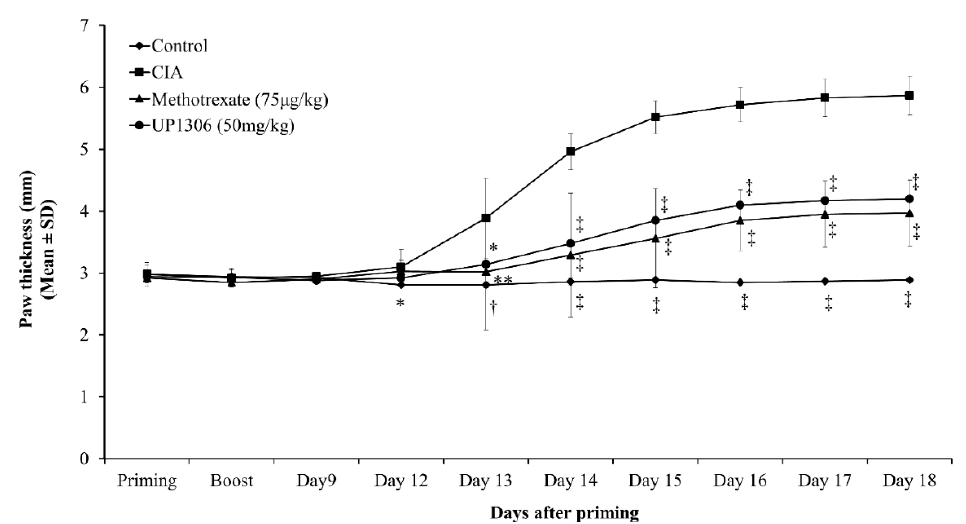
Figure 3. Changes in rat paw thickness in CIA model. Rats ( n = 10/group) were orally treated with UP1306 (50 mg/kg) and Methotrexate (75 μ g/kg) daily for three weeks post model induction. Data are mean ± SE. * p ≤ 0.05; ** p ≤ 0.001; † p ≤ 0.0001; ‡ p ≤ 0.00001 vs. CIA.